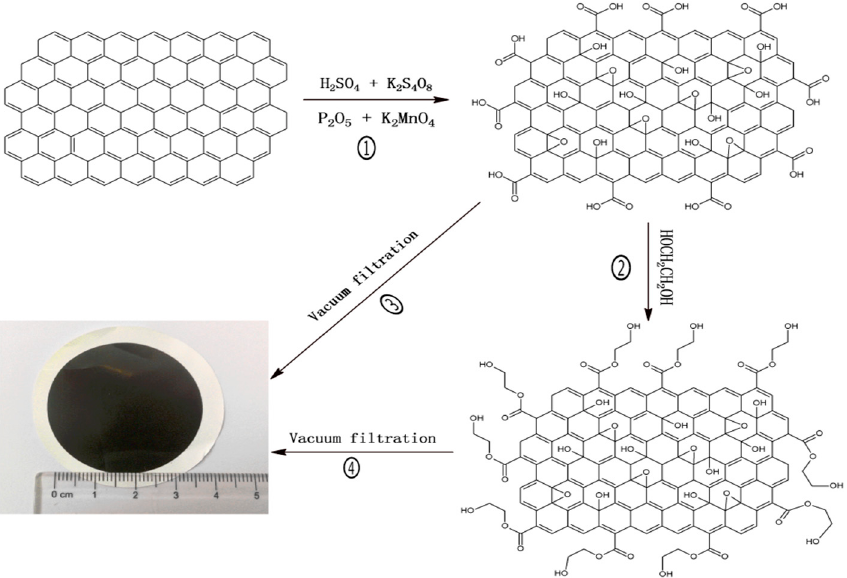
Figure 1. ( 1 (cid:13) , 2 (cid:13) ) shows the reaction process of GO nanosheets and GO/EG composite; ( 3 (cid:13) , 4 (cid:13) ) shows Figure 1. ( ① , ②) shows the reaction process of GO nanosheets and GO/EG composite; ( ③ , ④) shows the membrane preparation process of GO and the membrane preparation process of GO and GO/EG.